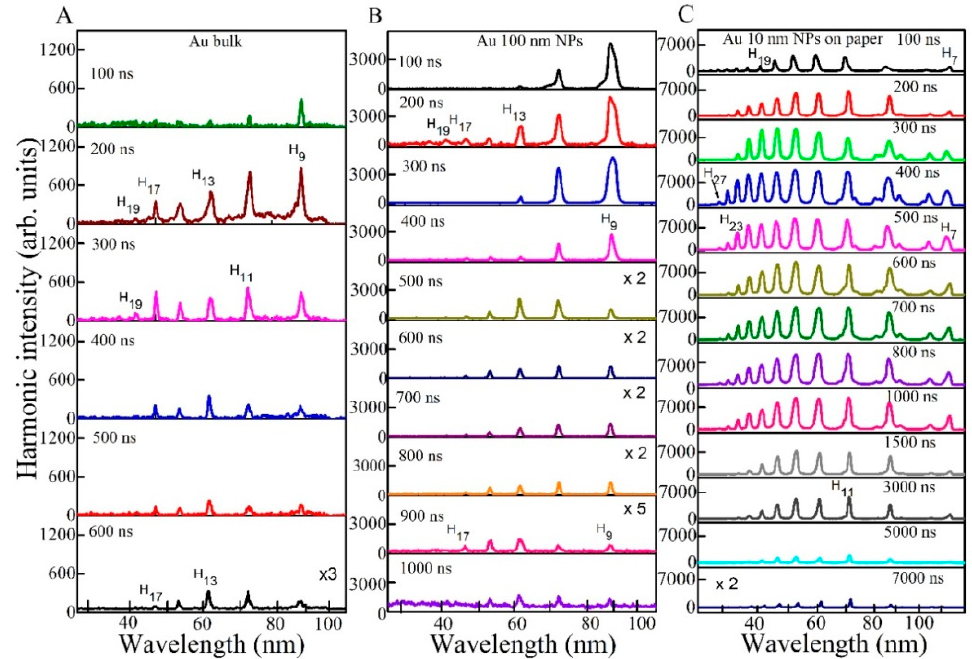
Figure 2. Harmonics spectra from the Au plasmas produced on three targets at different delays between the heating and driving pulses. ( A ) Bulk Au, ( B ) Au 100 nm NPs, ( C ) Au 10 nm NPs glued on